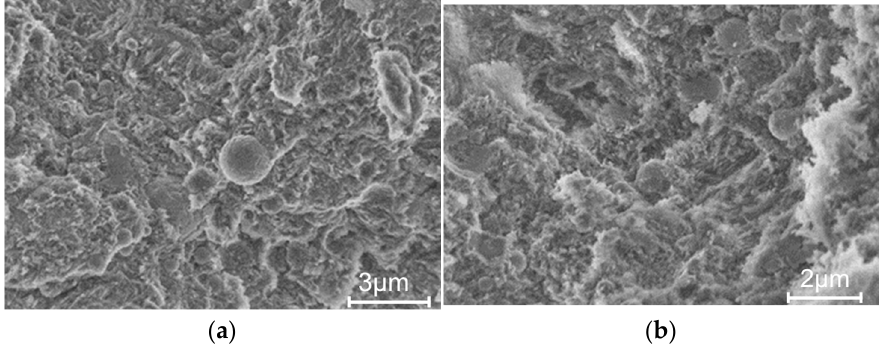
Figure 14. Morphology of 2.3 kg/m 3 cement sample: ( a ) non-corroded; ( b ) corroded.